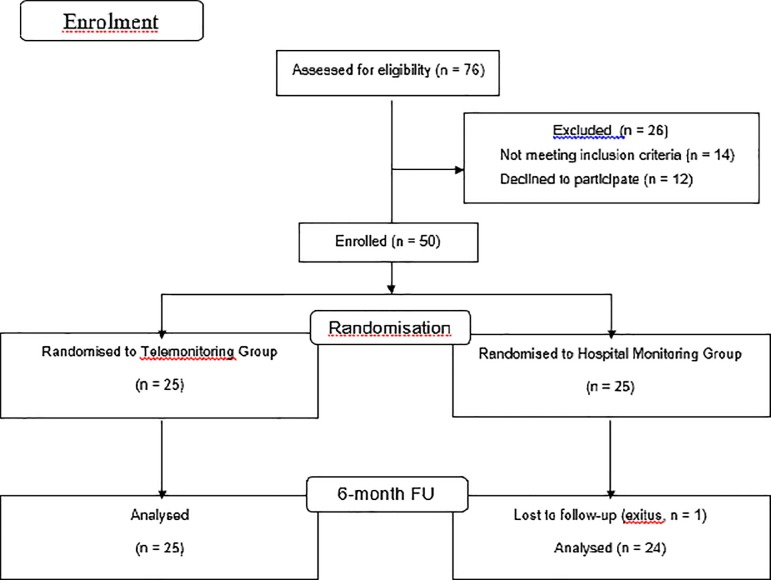
Flow (CONSORT) diagram of the study.